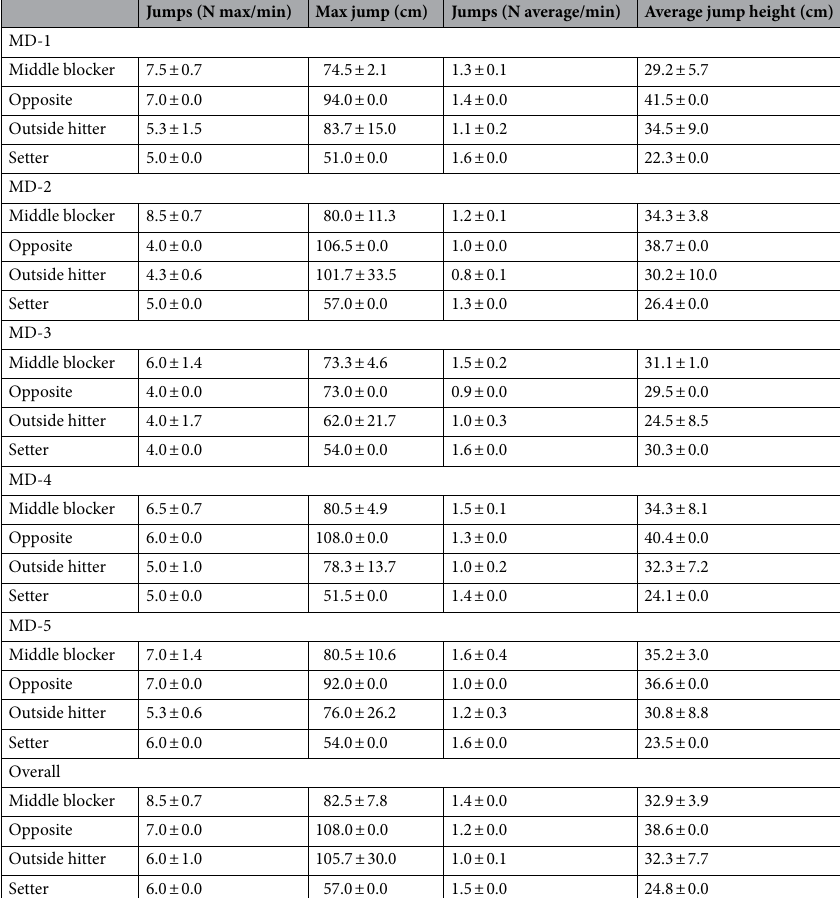
Table 2. Descriptive statistics (mean ± standard deviation) of the athletic performance measures obtained per minute in different playing positions and weekly training sessions.